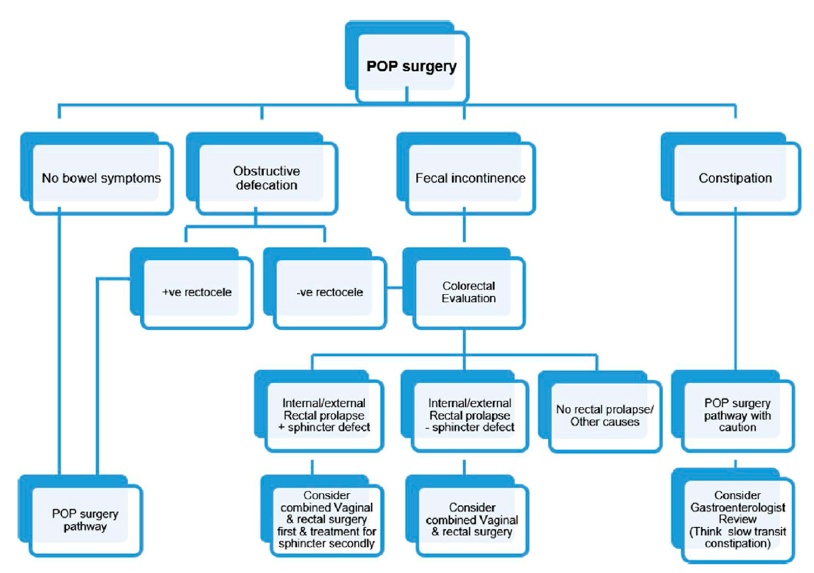
Figure 1. Suggested surgical pathway for prolapse repair with coexisting bowel symptoms.